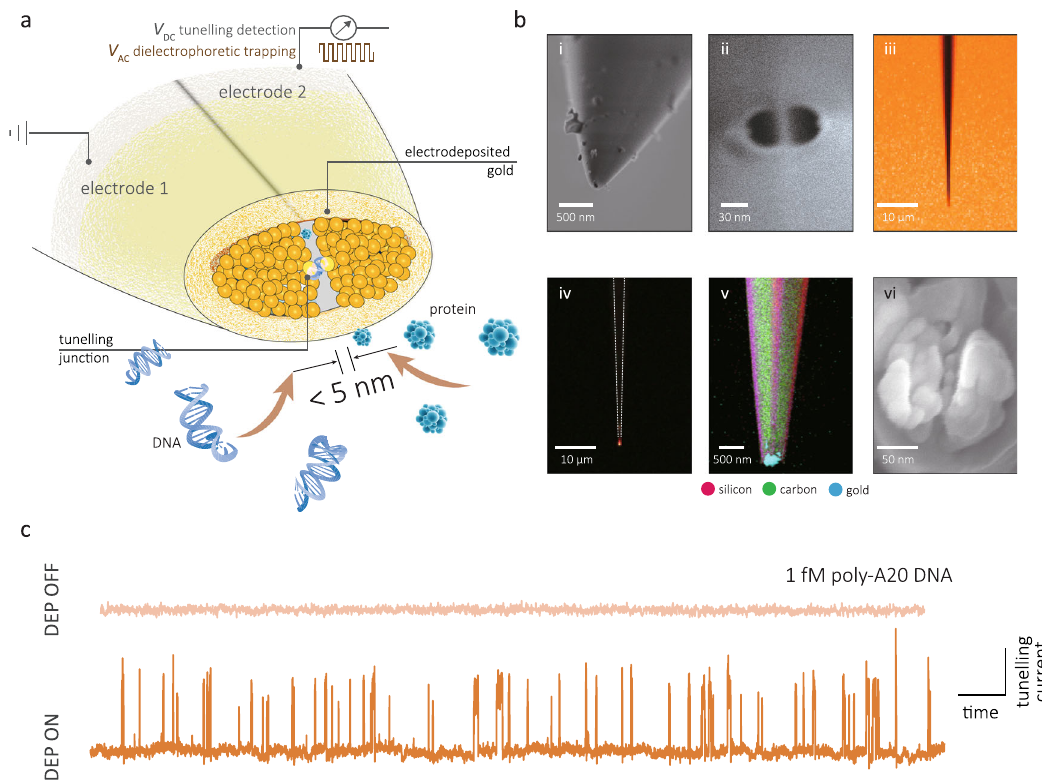
Fig. 1 Dielectrophoretic trapping-combined quantum mechanical tunnelling sensors for the detection of DNA and proteins. a Conceptual design of the QMT probe. DEP trapping was initiated by applying an AC electric fi eld while tunnelling was performed under a constant DC bias. Single-molecule tunnelling detection was performed on mononucleotides, small DNA oligomers and proteins. b The tunnelling junction was made from (i) double-barrelled glass capillaries that were laser pulled to nanoscale dimensions, as shown in (ii). Nanoscale electrodes were made using a combination of pyrolytic deposition of butane and electrodeposition of gold with real-time feedback. Optical images (iii – iv), scanning TEM-energy dispersive spectrometry (v) and SEM imaging (vi) clearly show gold at the tip of the probe. c Typical tunnelling current – time trace as shown for DNA at a concentration of 1 fM with and without applying a dielectrophoretic trap. The scale bar along the x- axis is 5 ms and along the y- axis is 20